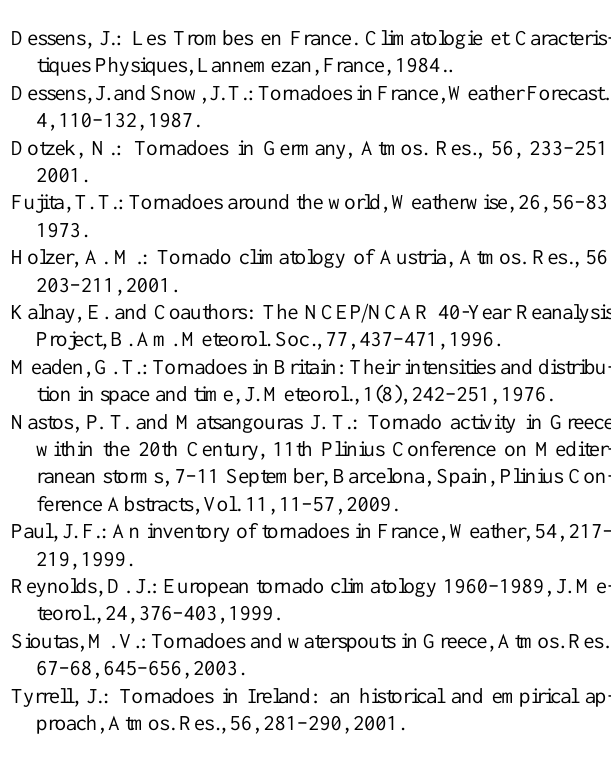
Figure 5. Sequence of satellite images at: (a) 09:30UTC, (b) 10:00UTC, (c) 10:30UTC and (d) 11:00UTC on 27 July 2002 from visual spectrum (VIS 0.6 µ m) of Meteosat 7 (Eumetsat). Red arrow indicates the associated storm that formed the tornado over the Athens International